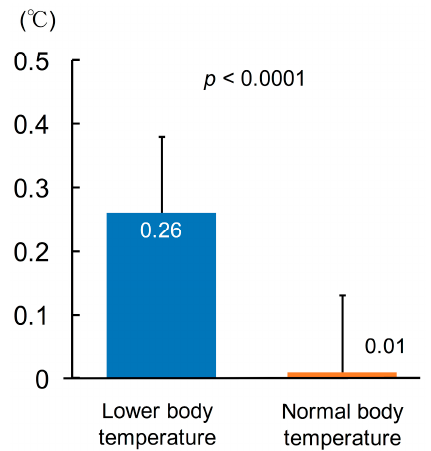
Figure 3. The amount of changes in body temperature after exercise training. The number of changes in body temperature from baseline to 2 years had a strong correlation with baseline body temperature (Figure 4).